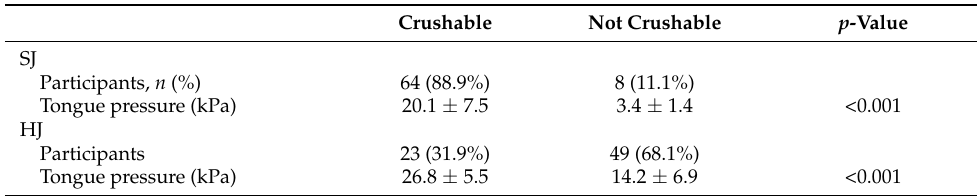
Table 6. Crushability by tongue crush ( n = 72).